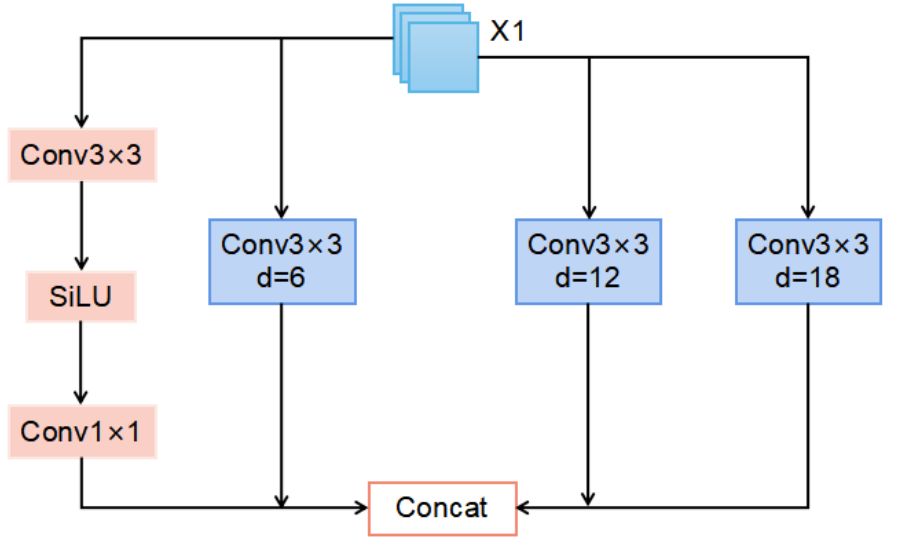
Figure 2. Structure diagram of cross extraction module.